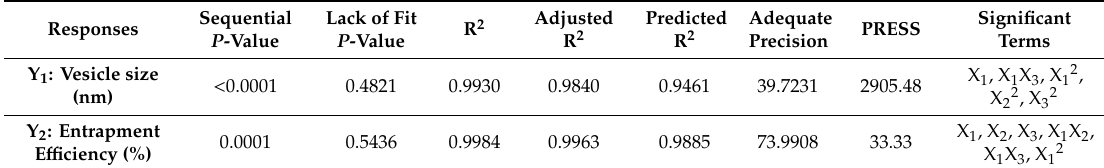
Table 3. Statistical analysis of FLB niosomes responses according to the quadratic